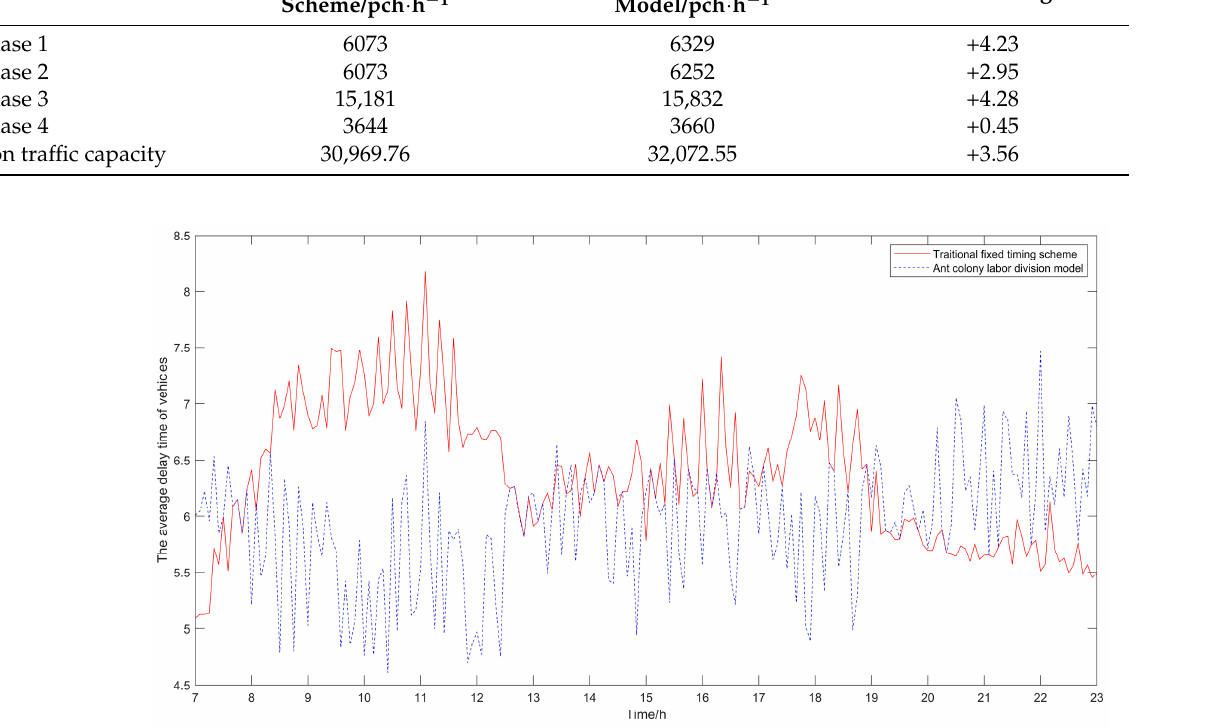
Figure 7. Comparison diagram of traffic capacity at intersections.